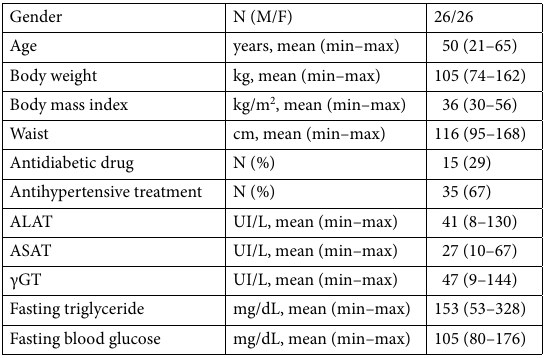
Table 1. Patients population. ASAT aspartate aminotransferase, ALAT alanine aminotransferase, γGT γ-glutamyl transferase.